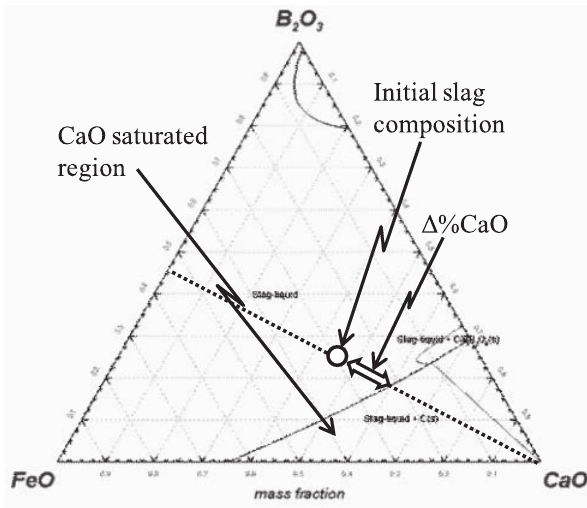
Fig. 3: Phase diagram of FeO-CaO-B 2 O 3 slag calculated by